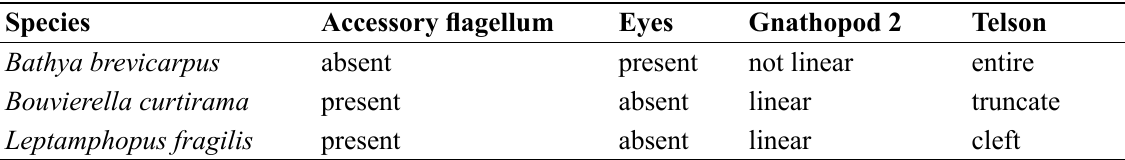
Table 1. Synoptic table comparing Bathya brevicarpus gen. et sp. nov. and congeneric calliopiids reported from vent fields on the basis of literature